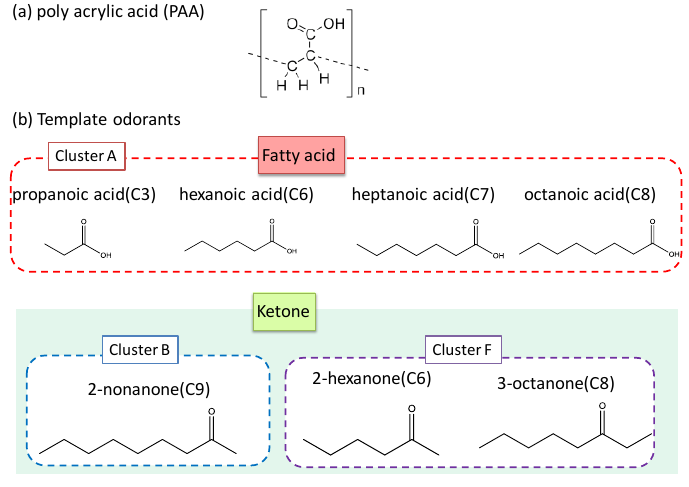
Figure 2. The molecular structures of PAA and template odorants. Three types of fatty acids and ketones were chosen. These odorants belong to cluster A, B, or F.